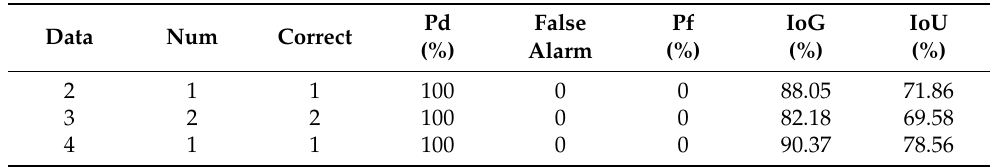
Table 2. Performance of RADARSAT-2 polarimetric SAR data for sea-crossing bridge detection in Fuzhou, Fujian, Zhanjiang, Guangdong, and Singapore regions, where Num denotes the number of targets. Pd denotes the detection rate. Pf denotes the false alarm rate. IoG denotes the intersection over ground-truth. IoU denotes the intersection over